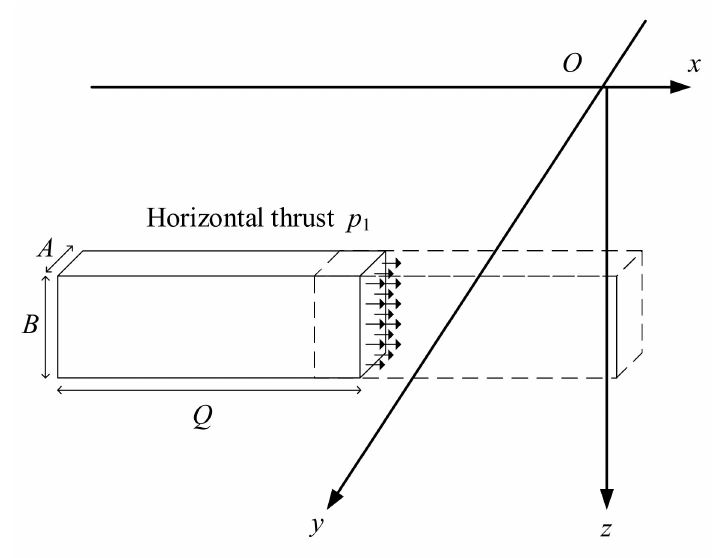
Figure 4. Areas of integration of additional horizontal